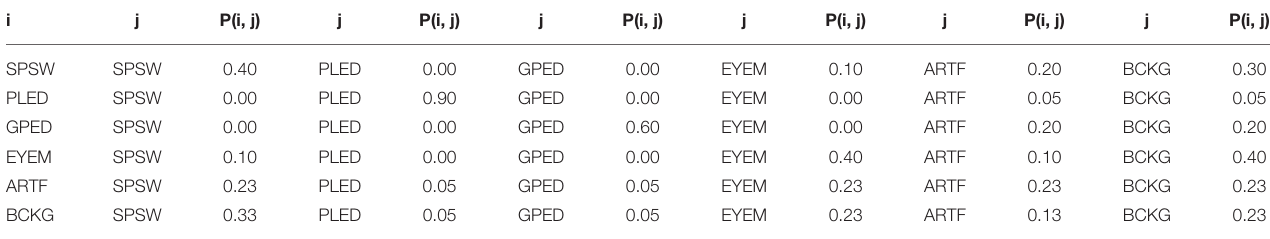
TABLE 2 | A bigram probabilistic language model for the third pass of processing which models all possible transitions from one of the six classes to the next.